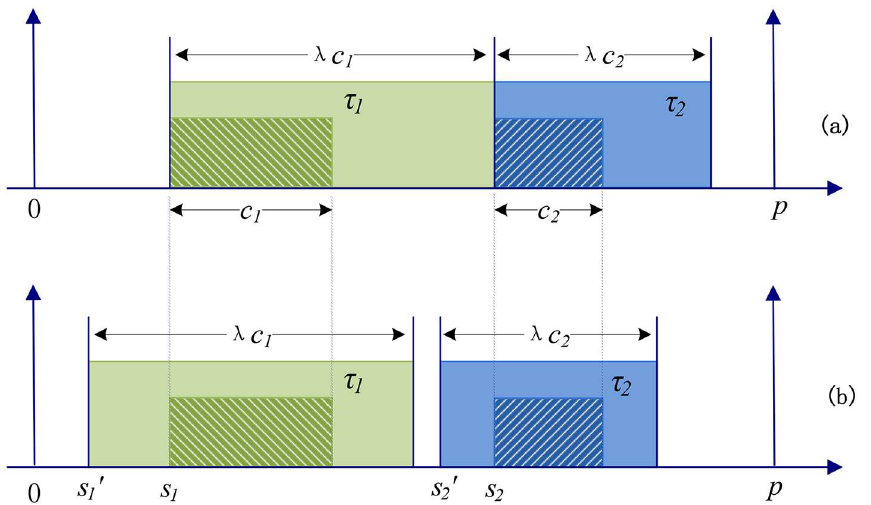
Fig 3. Impact of the scaling factor λ on the computation times of two